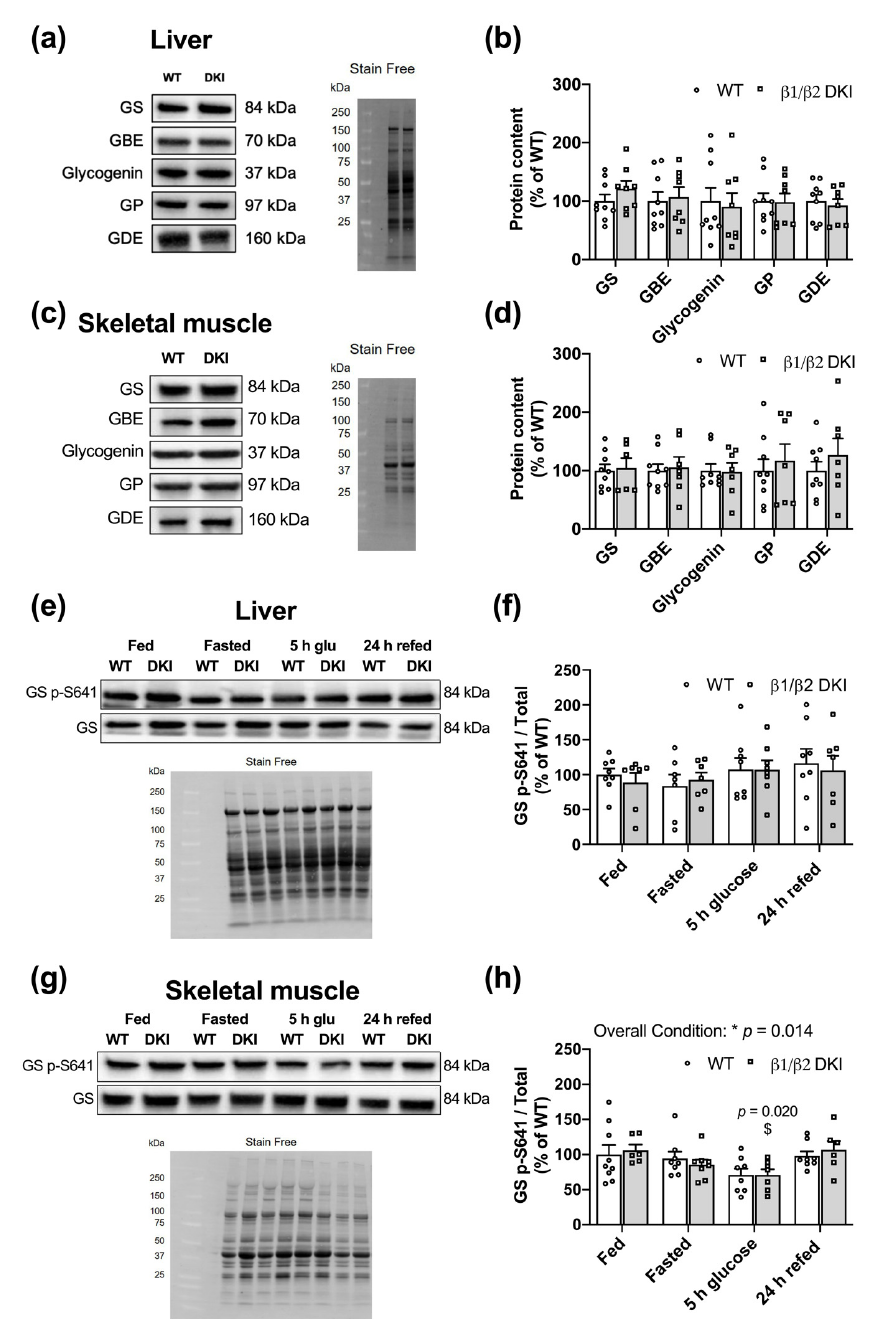
Figure 6. Liver and skeletal muscle from DKI mice display no alterations in content of glycogen-associated proteins. Tissues were collected from fed male mice and assessed for glycogen-associated protein content and phosphorylation status. ( a ) Representative immunoblots and stain-free image for DKI versus WT liver. ( b ) Quantified glycogen synthase (GS), glycogen branching enzyme (GBE), glycogenin, glycogen phosphorylase (GP), and glycogen debranching enzyme (GDE) in liver. ( c ) Representative immunoblots and stain-free image for DKI versus WT skeletal muscle. ( d ) Quantified GS, GBE, glycogenin, GP, and GDE in skeletal muscle. To assess phosphorylation of GS S641, liver and skeletal muscle were collected from male mice in the fed and overnight fasted states, and 5 h- and 24 h-post-administration of a glucose bolus (3.6 g · kg − 1 total body mass) via oral gavage. The 24 h-post cohort had ad libitum access to chow beginning at 5 h-post glucose gavage. Representative immunoblots and stain-free images for DKI versus WT ( e ) liver and ( g ) skeletal muscle. Quantified GS p-S641 relative to total protein in ( f ) liver and ( h ) skeletal muscle. Fed male mice, n = 7–9, 20–32 wk. $ p < 0.05 versus fed condition from same genotype; * p <